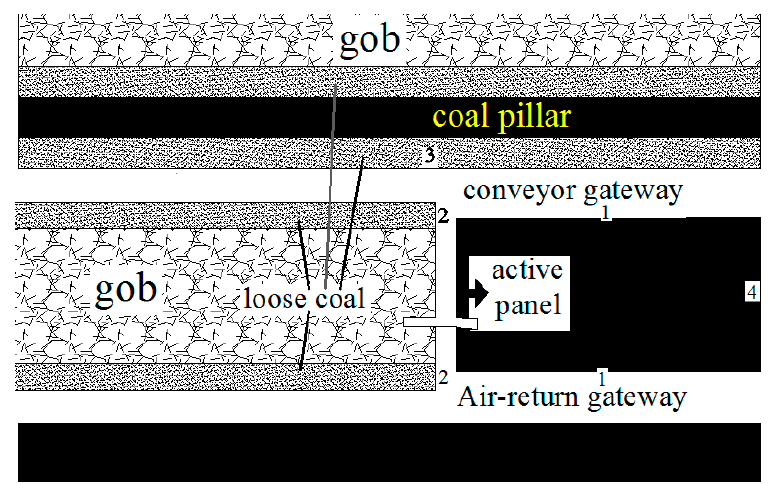
Figure 10. Spontaneous combustion-prone areas in CLTCC.